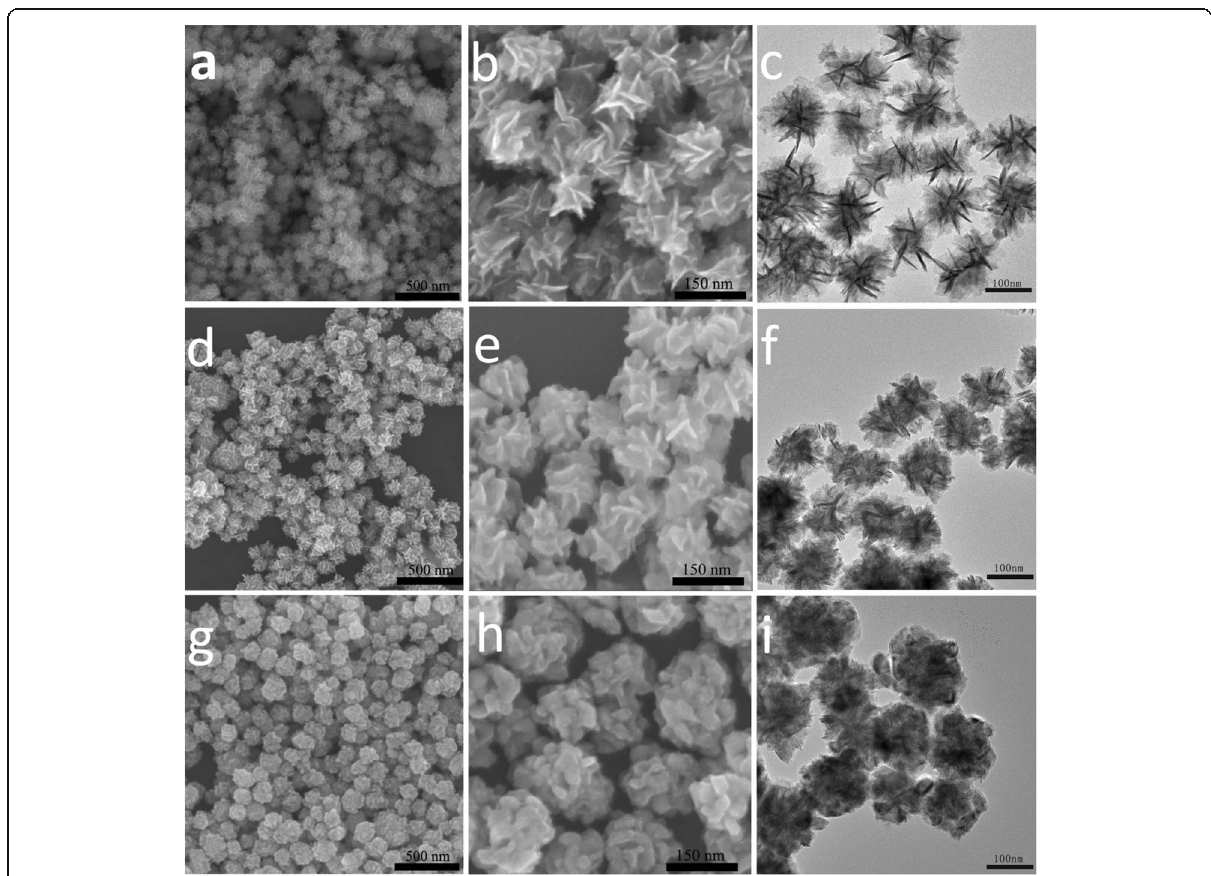
Fig. 3 SEM images ( a , b , d , e , g , and h ) and TEM images ( c , f , and i ) of Mo5Ni1 ( a − c ), Mo2Ni1 ( d − f ) and Mo1Ni1 ( g − i ) samples